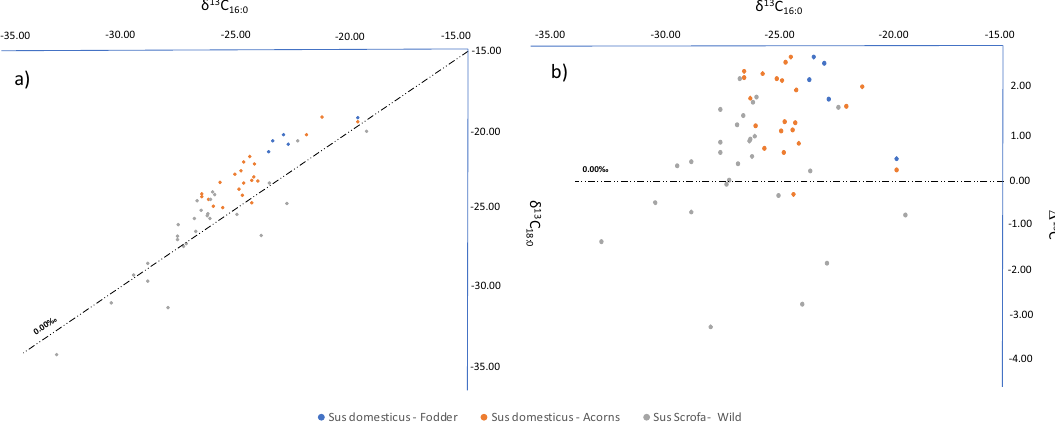
Figure 5. ( a ) Scatter plot showing δ 13 C 16:0 values (X axis) and δ 13 C 18:0 values (Y axis), and ( b ) δ 13 C 16:0 values (X axis) and Δ 13 C (= δ 13 C 18:0 − δ 13 C 16:0 ) values (Y axis) of fatty acids extracted from Pigs ( Sus domesticus ) with a fodder-based feed (blue); fed by acorns, grasses, legumes and wild fruits (Orange); and Wild boars ( Sus scrofa ) (grey).